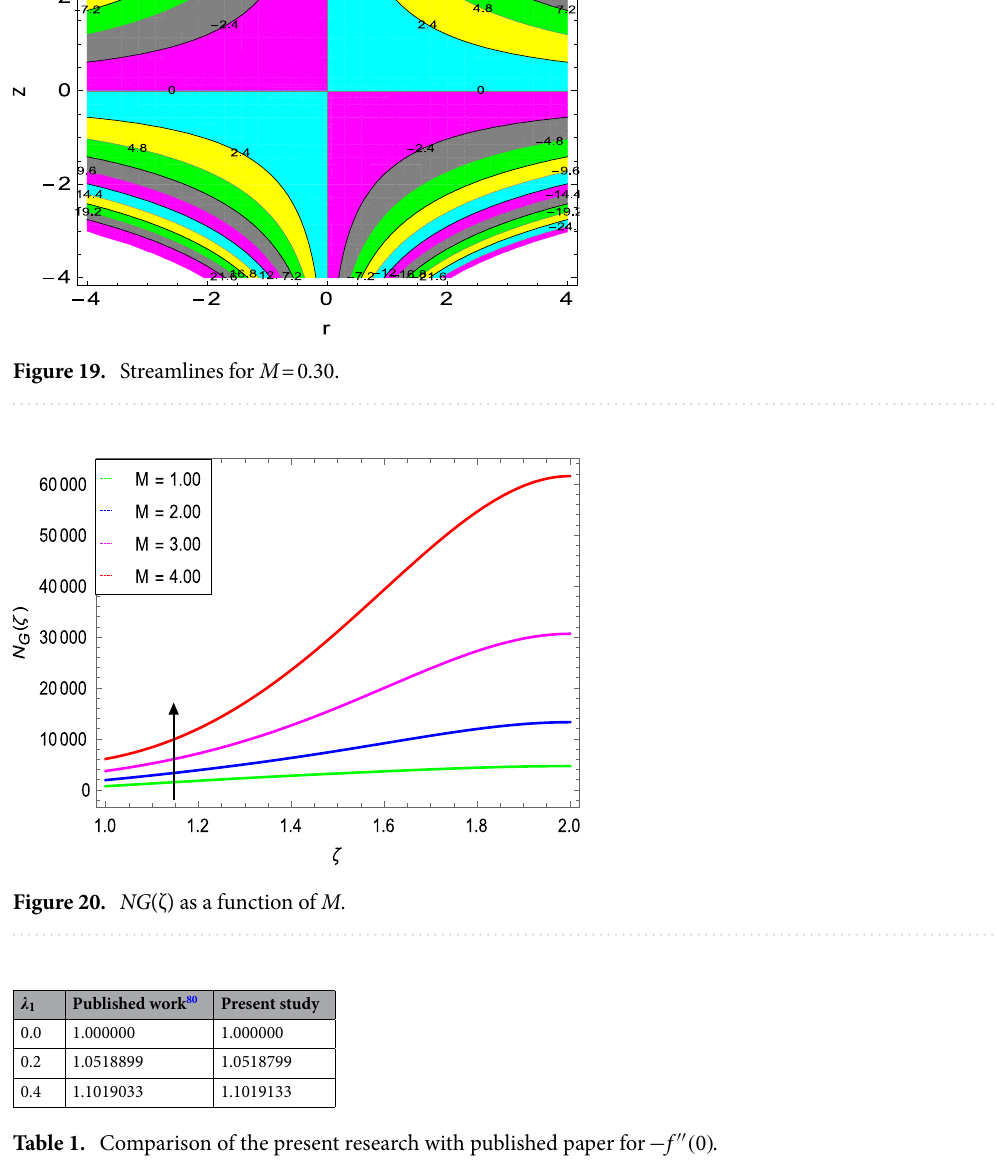
Table 1. Comparison of the present research with published paper for